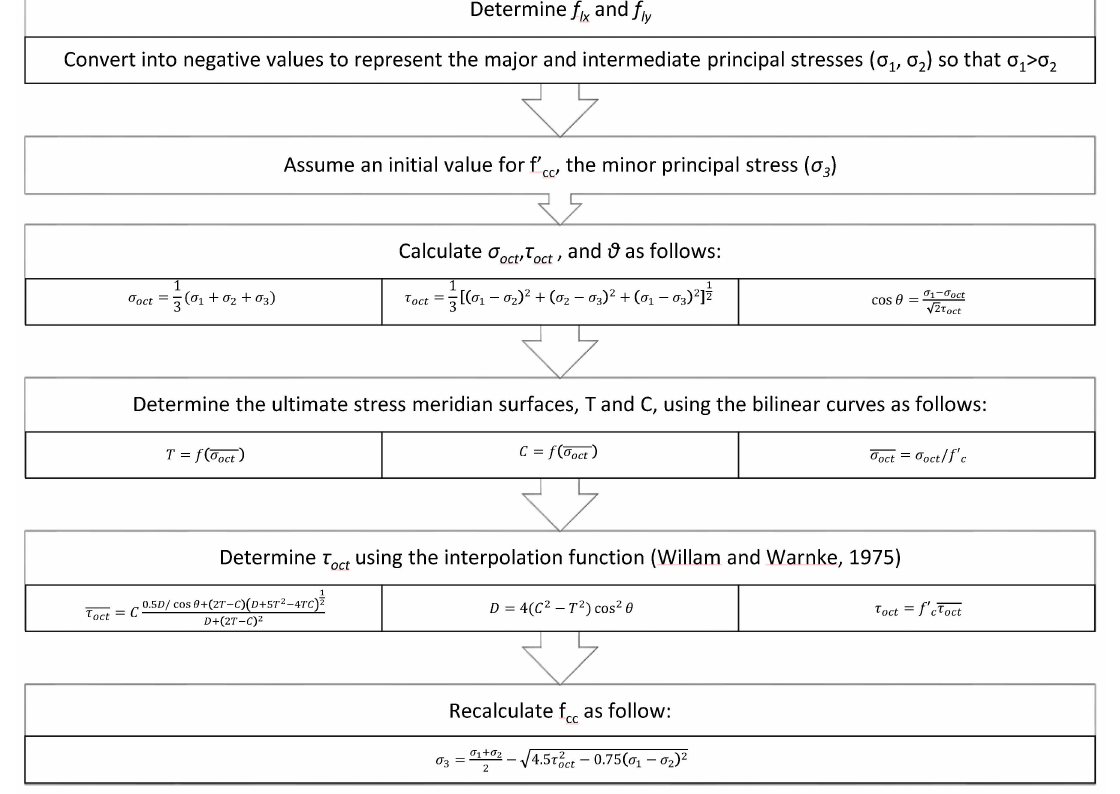
Figure 13. Confined compressive strength determination procedure.